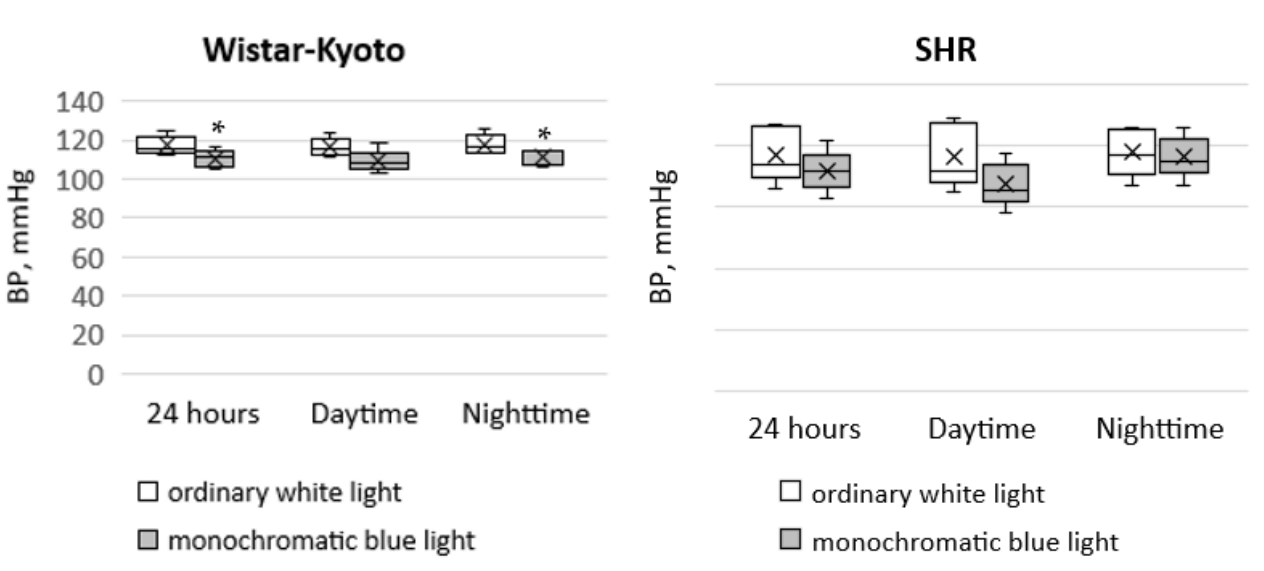
Figure 1. Indicators of the telemetric monitoring of SBP in Wistar–Kyoto and SHR rats under the standard light pattern (12 h:12 h) with ordinary white light and monochromatic blue light. *— p ≤ 0.05.